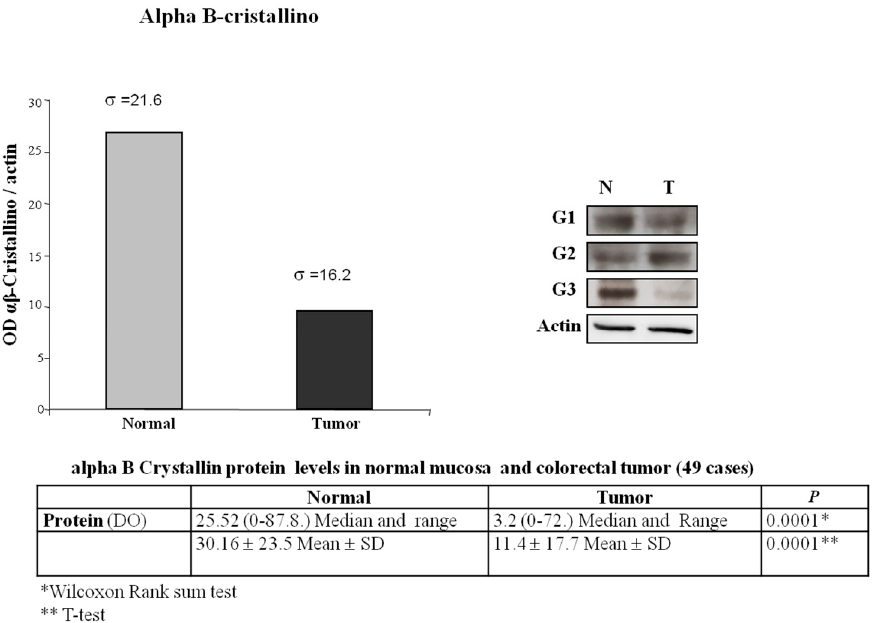
Figure 2. Optical density and Western blot of CRYAB protein expression in CRC tissues (T) and adjacent non-cancerous mucosa (N) from the same patient.